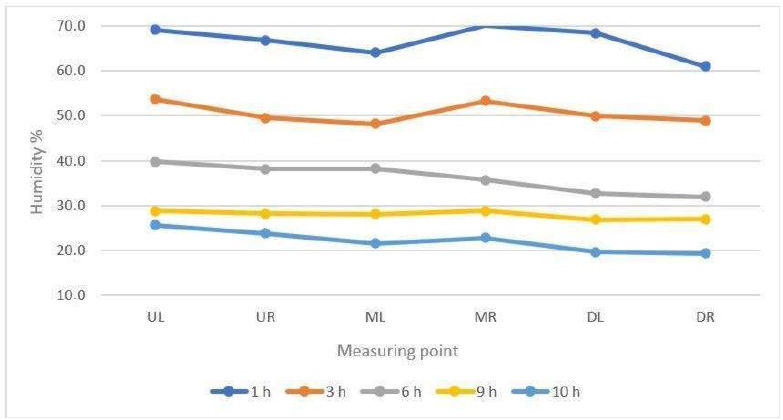
Figure 11. Changes in moisture content of beef samples taken from different zones of the drying chamber, chamber 4.